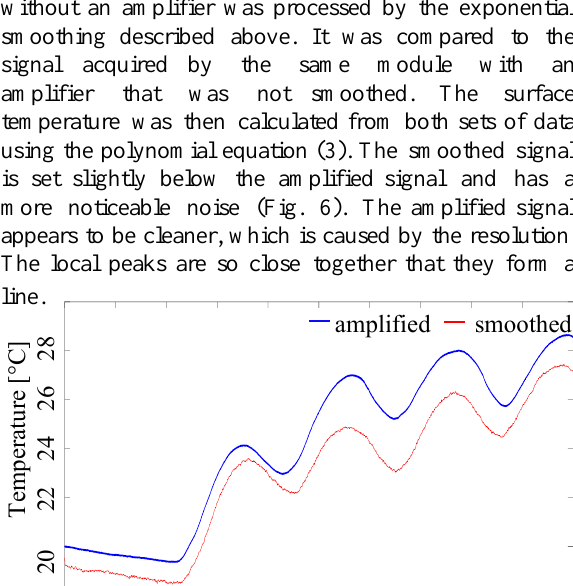
Fig. 4. Signal with amplifier noise and the original signal